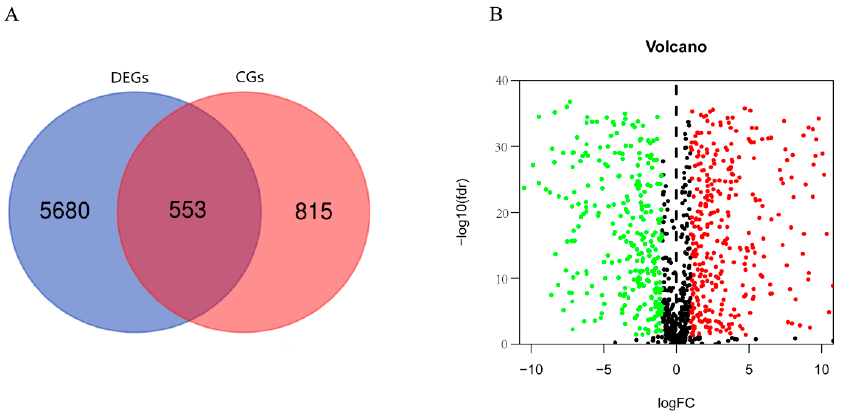
Figure 2. DERGs identification ( p . adjust < 0.05, |log2FC| > 2). ( A ) Gene cross plot of KIRC and CGDB datasets; ( B ) volcano map of DERGs. The red and green dots represent the up-regulated and down-regulated genes, respectively.